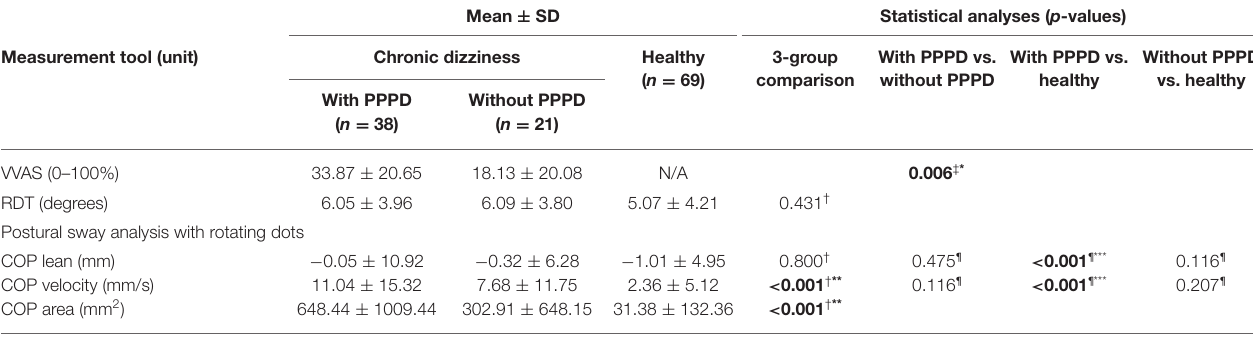
TABLE 4 | Results on clinical visual dependence tests of the included participants a,b . Measurement tool (unit) Chronic dizziness Healthy